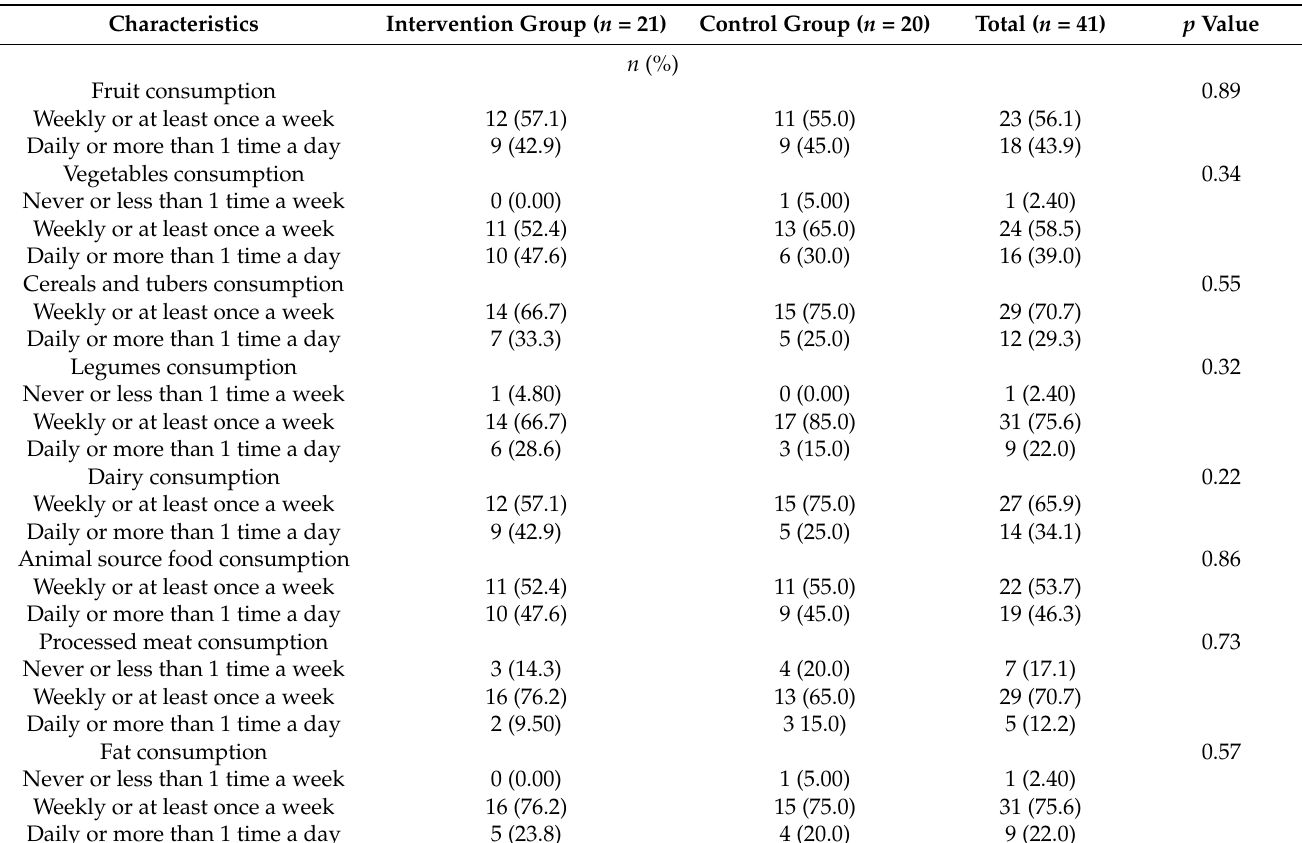
Table A2. Food consumption of the intervention group (Planet Nutrition program) and control group participants at 9 weeks of the